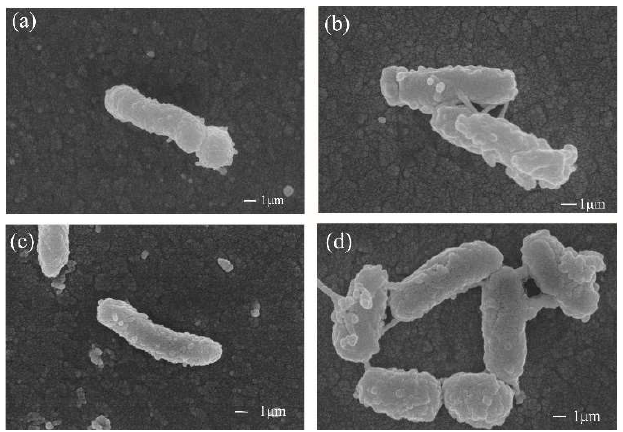
Figure 7. Scanning electron micrographs of strain FG2 and strain CB1 in different medium for 10 h. ( a ) Strain CB1 in 2216E medium; ( b ) strain CB1 in M1 medium containing 500 mg/L malathion. Cells of CB1 are regular rod morphotype with protuberances on the surface. ( c ) Strain FG2 in 2216E medium; ( d ) strain FG2 in M1 medium containing 500 mg/L malathion; cells of FG2 are regular rod morphotype with protuberances on the surface.